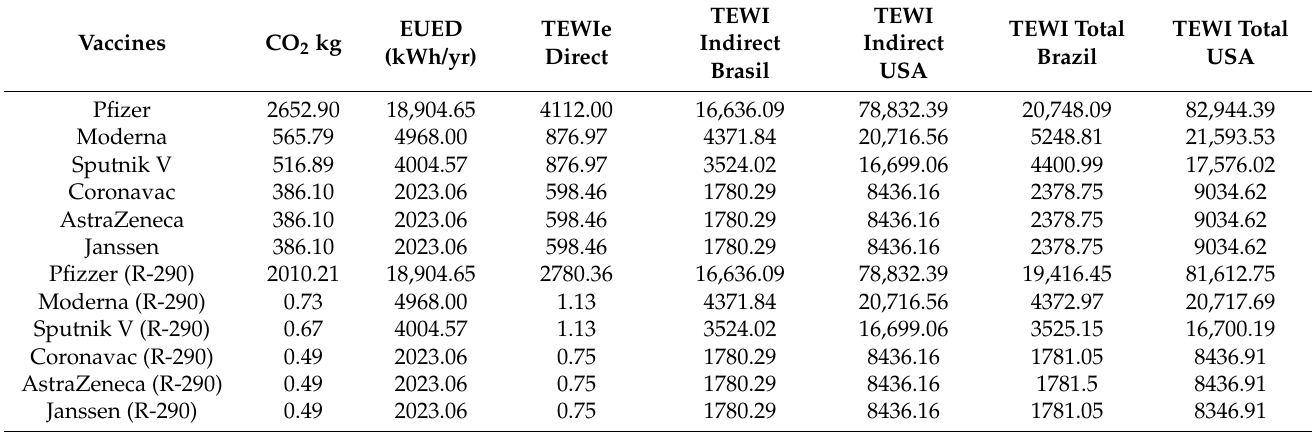
Table 7. Indirect and direct TEWI of each vaccine refrigeration system for the USA and Brazil.